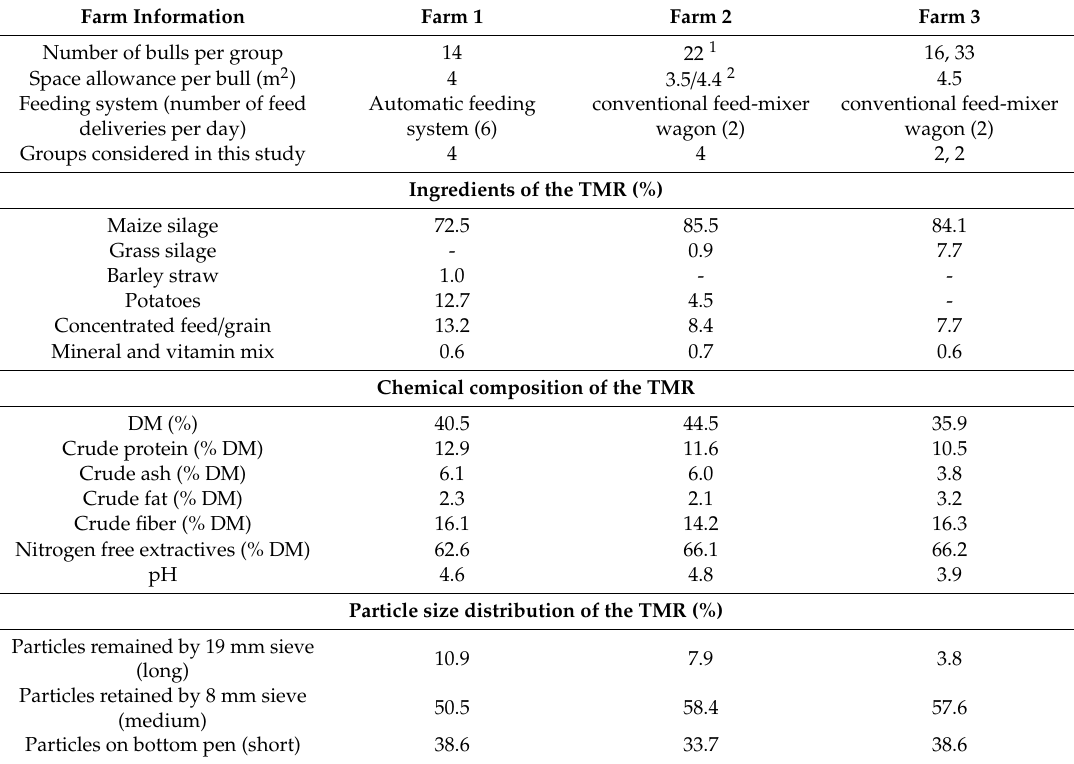
Table 1. Housing information for the observed animals. TMR = total mixed ration, DM = dry matter. Farm Information Farm